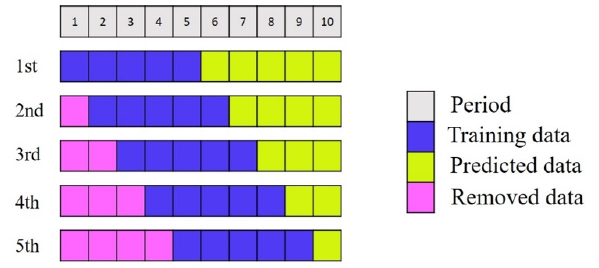
Figure 3. Rolling forecast schematic.